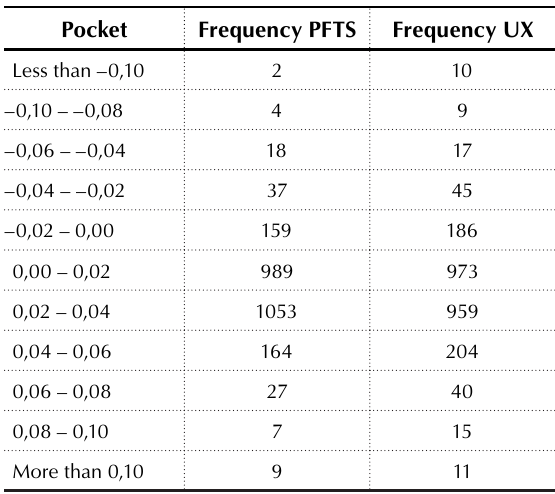
Table 1. Frequency analysis of daily